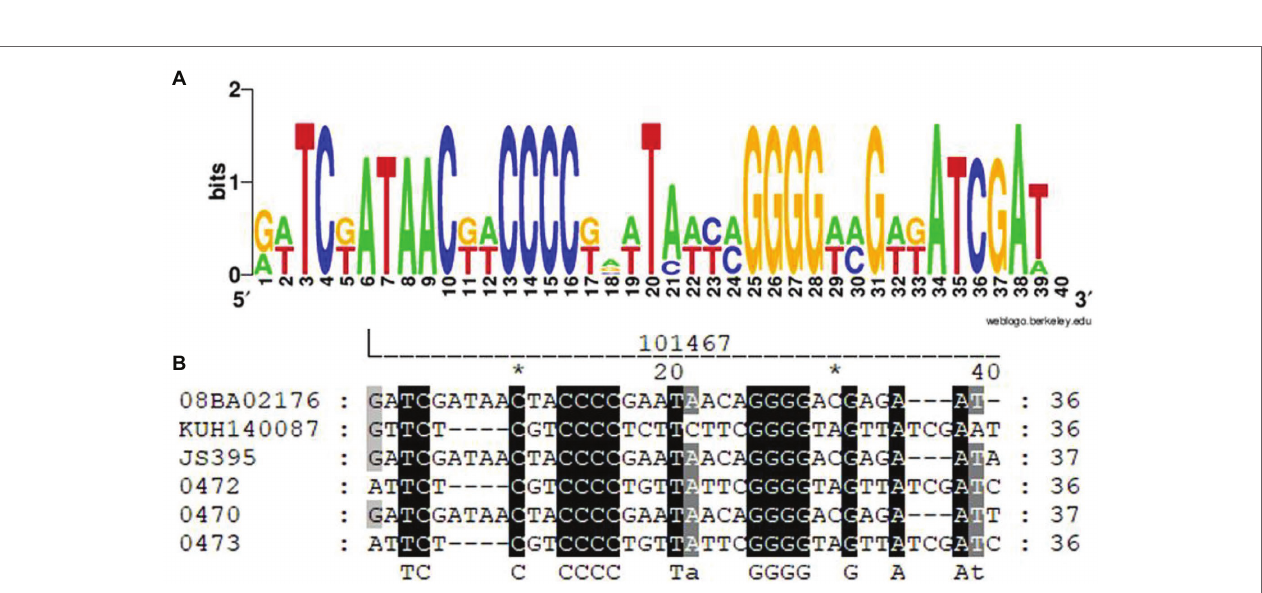
FIGURE 3 | SRc alignment of the CRISPR-Cas system present in S. aureus . Visualization (A) and alignment of nucleotides (B) . The motive nucleotides are under the alignment (capital letters). The alignment was done with MUSCLE (UGENE), and the image was obtained from WebLogo (A) and GeneDoc (B) .